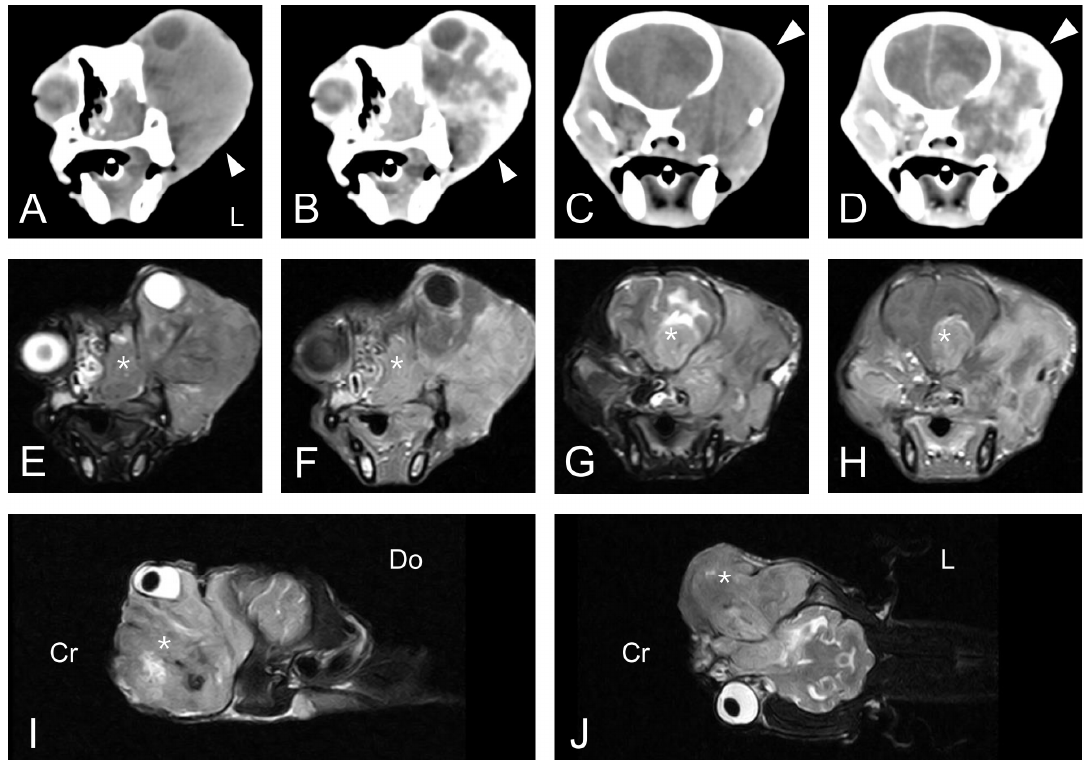
Figure 2. Transverse-plane computed tomography (CT) images ( A – D ), magnetic resonance images (MRI) ( E – H ) at the level of the eye globes and the brain, and left parasagittal ( I ) and dorsal plane ( J ) MRI are depicted. Both pre-contrast ( A , C ) and post-contrast ( B , D ) CT images demonstrated an ill-defined, heterogeneous, contrast-enhanced soft tissue mass (arrowhead) extending from the left nasal cavity to the left pterygopalatine fossa. Sequential MRI revealed an equivalent lesion that was hyperintense on T2W ( E , G , I , J ) and irregularly enhanced on CET1W images ( F , H ). The space-occupying mass (asterisk) with vasogenic edema caused significant mass effect and midline shift to the affected side of the brain. L, left; Cr, cranial; Do, dorsal